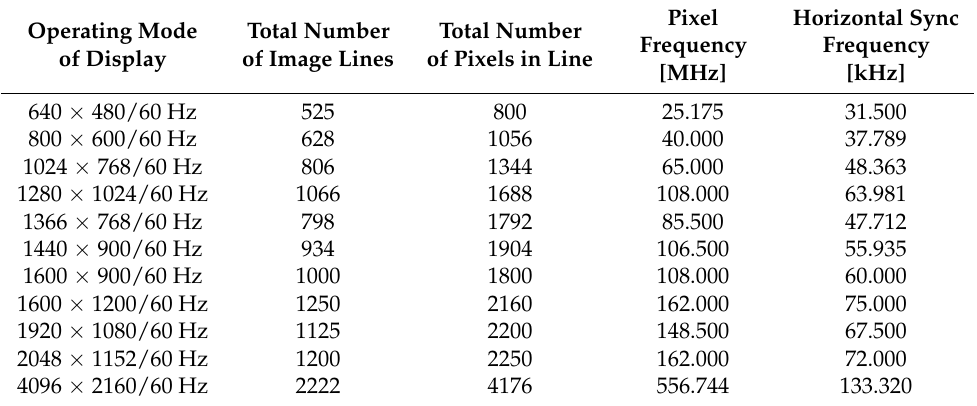
Table 1. Nominal parameters for selected graphic modes according to VESA [50].